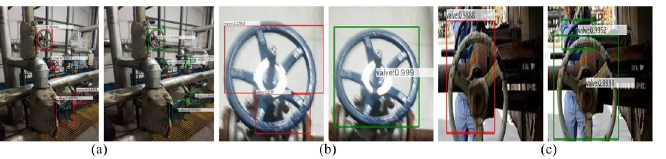
Fig 10. Comparison diagram of valve detection. (a) Small scale valve detection (b) Large scale valve detection (c) Occlusion overlap valve detection. In Fig (a), (b) and (c), the left-hand picture is the detection result of the Faster R-CNN algorithm, and the right-hand picture is the detection result of the ROMS R-CNN algorithm. The label in the figure marks the name and confidence of the object. In Fig (a), there are two small scale valves. The left picture fails to be detected, resulting in missed detection, and the right picture successfully detected. In Fig (b), the valve scale is too large. On the left, one valve is detected as two, resulting in false detection. On the right, large-scale valves are successfully detected. In Fig (c), the valves are overlapped seriously with each other.